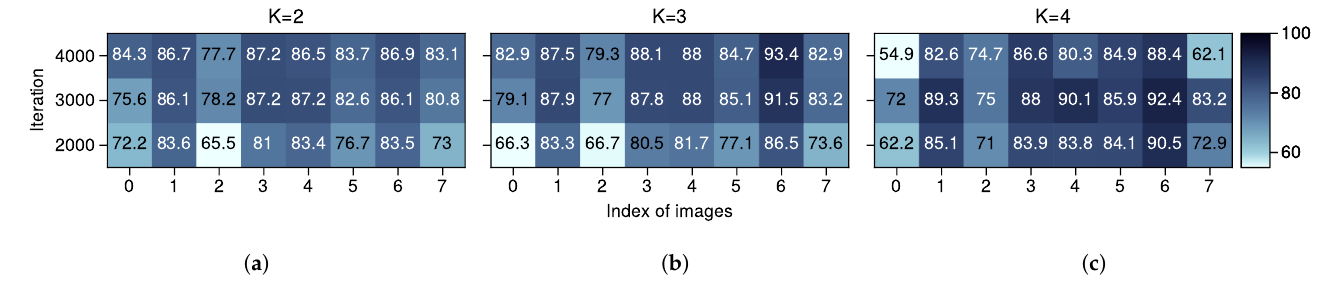
Figure 11. Averaged quality (%) of incorrect pseudo-labels with different K on POT → VAI, calculated from the same images in Figure 8. ( a ) K = 2. ( b ) K = 3. ( c ) K = 4.